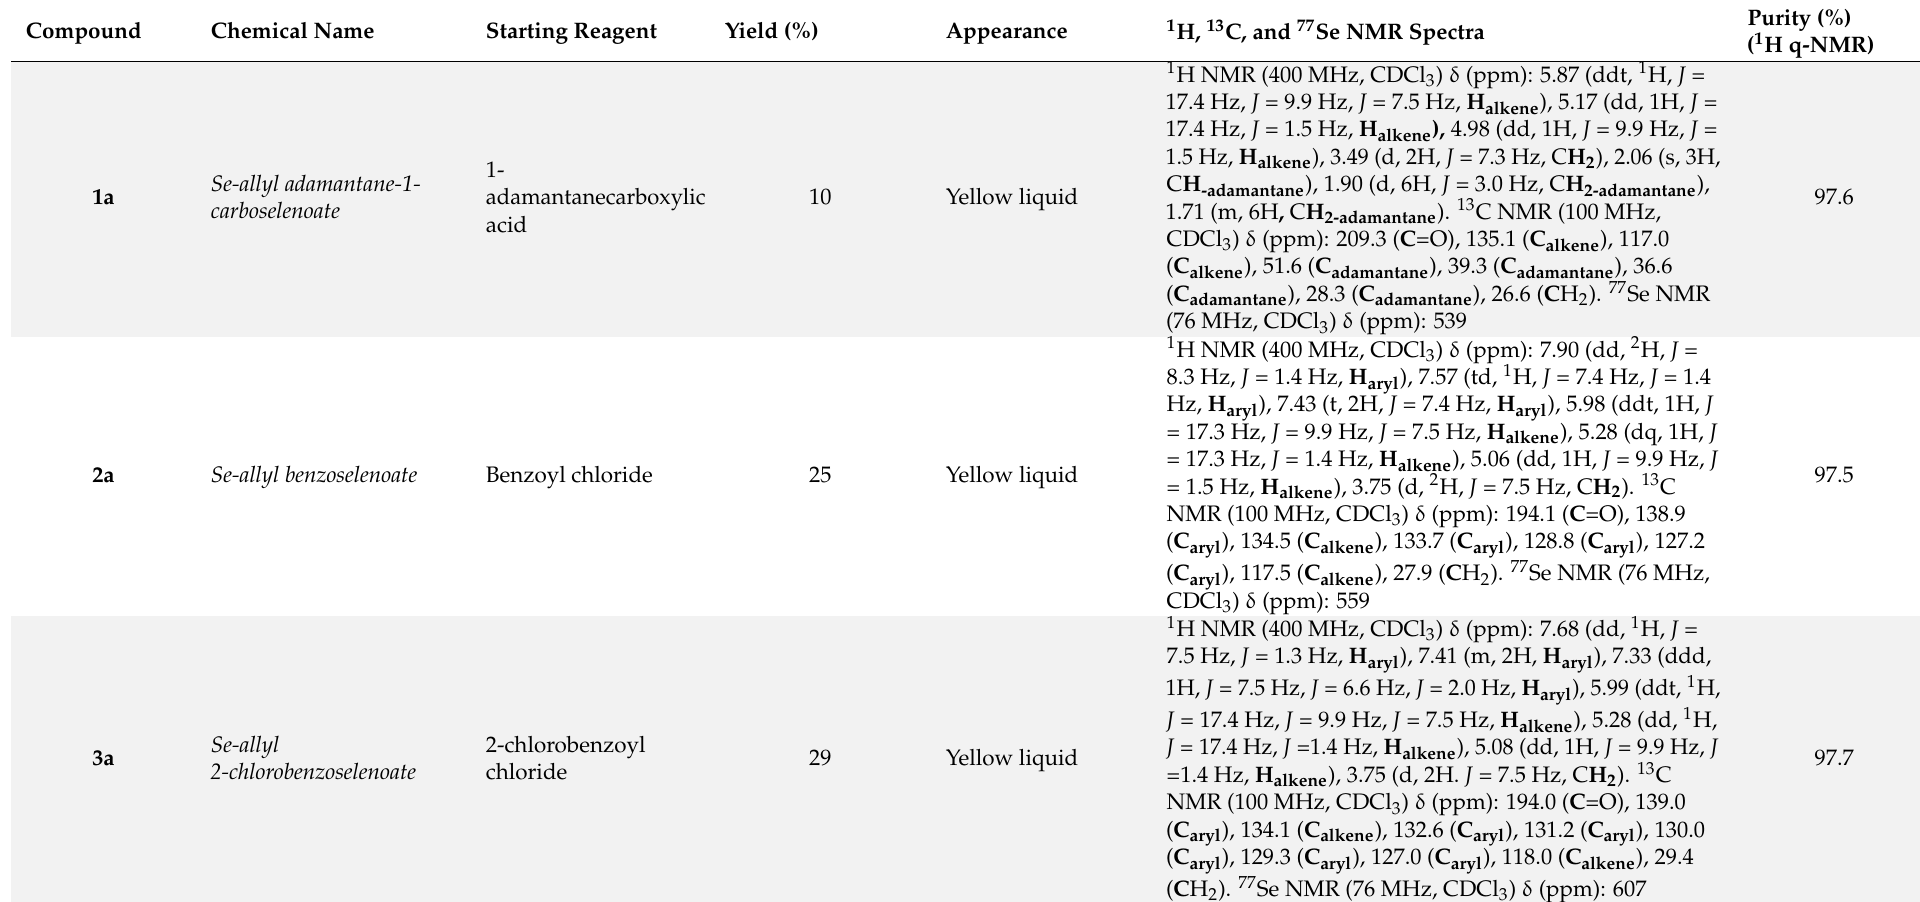
Table 1. Chemical name, starting reagent, yield (%), appearance, spectroscopical characterization by NMR and purity (%) of compounds from series a .